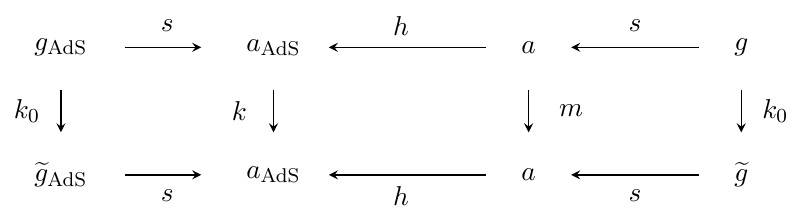
Figure 1 . A diagram of transformations underlying the relation between the redundancy and the isometry. The maps (2.40) and (2.41) define h and k . A commutativity in the middle rectangle yields m = h − 1 kh defining a stability transformation, a = m − 1 a k + k − 1 ˙ k , cf. (2.41). The gauge group elements on the left and right parts of the diagram are transformed by left multiplications by k 0 . The map s assigns connections to group elements according to